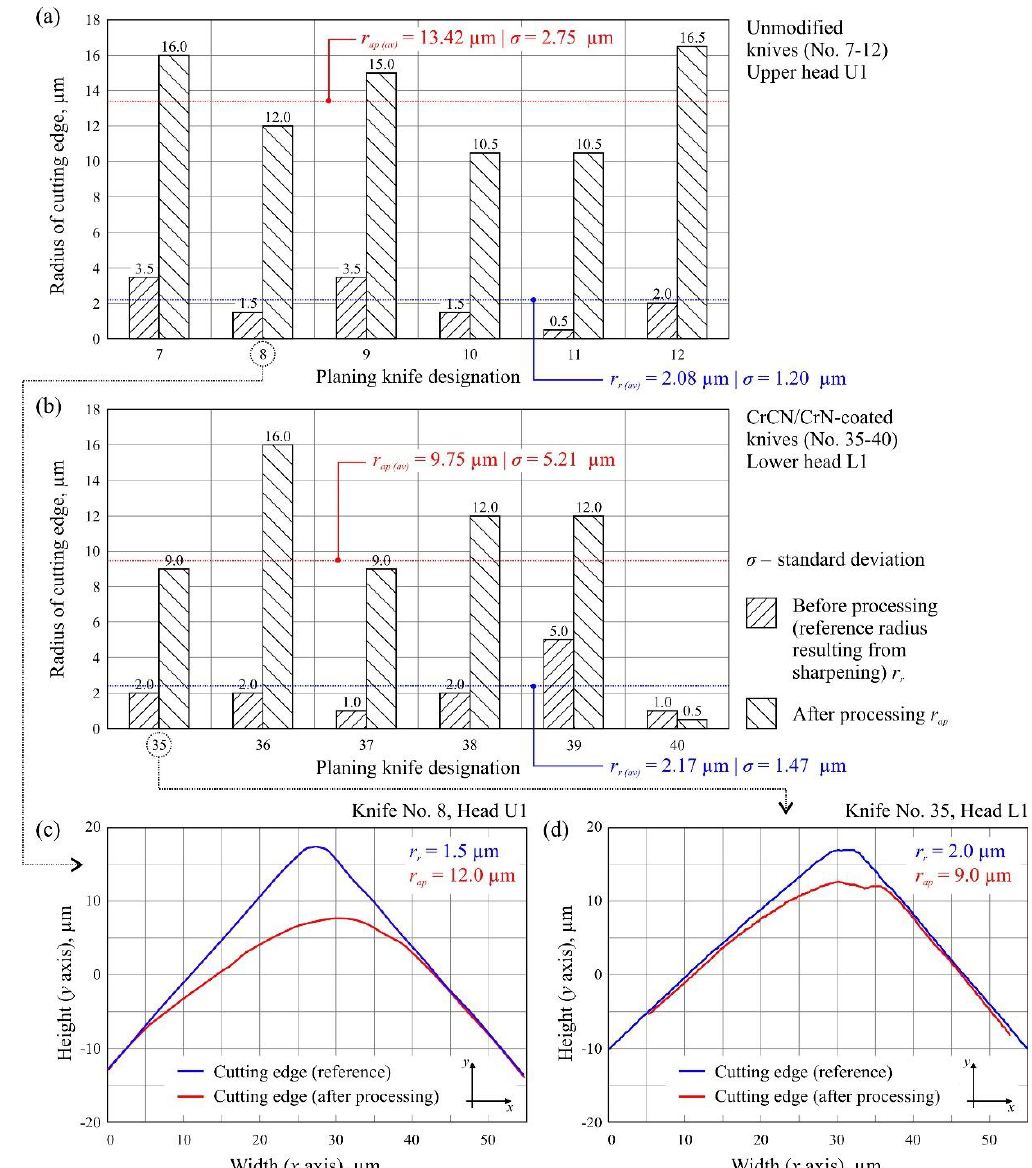
Figure 7. Measurement of the radius of the cutting edge of planer knives for ( a ) unmodified knives No. 7–12 and ( b ) CrCN / CrN-coated knives No. 35–40. Examples of specific values of the radius for ( c ) knife No. 8 (Set 1, Head U1) and ( d ) knife No. 35 (Set 1, Head L1).